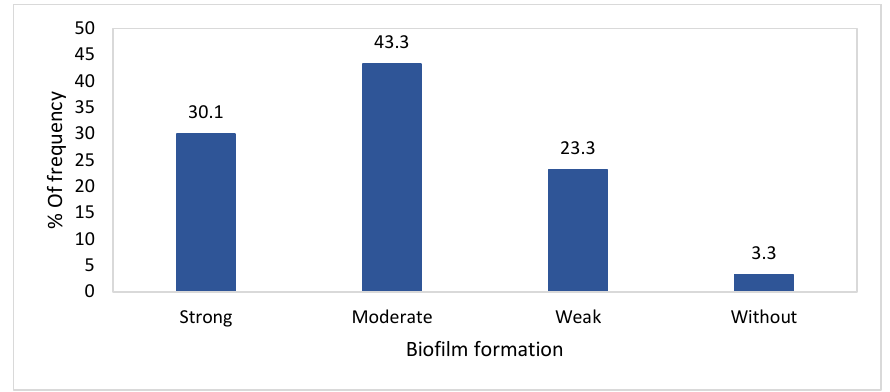
Figure 2. Frequency of Pseudomonas aeruginosa Isolates Based on Biofilm Production.